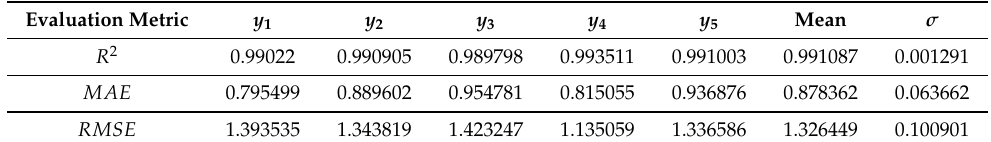
Table 8. The performance metric values achieved with the best combination of SEs on the en- tire